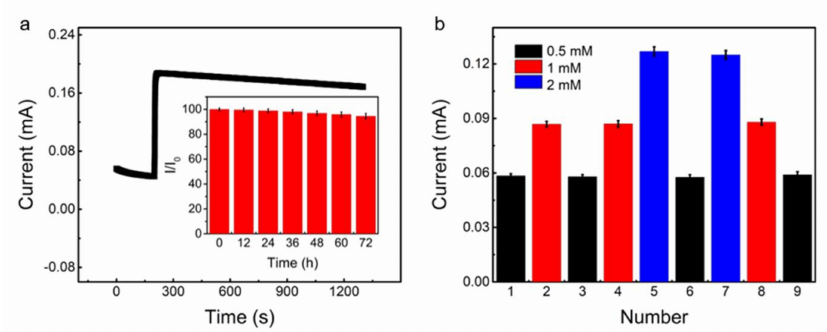
Figure 8. ( a ) Amperometric response of the (Cu 13nm -CNTS) 3 @fiber electrode by addition of 1 mM glucose into the PBS solution and stored for a long period of running time (1000 s), The inset is the repeated measurements of the calibration curve of the relevant amperometric signal of the sensor electrode with an interval of 12 h in PBS solution during 72 h, with 1.0 mM glucose at +0.35 V. ( b ) The calibrated consecutive measurements of the (Cu 13nm -CNTS) 3 @fiber electrode in glucose solution with different